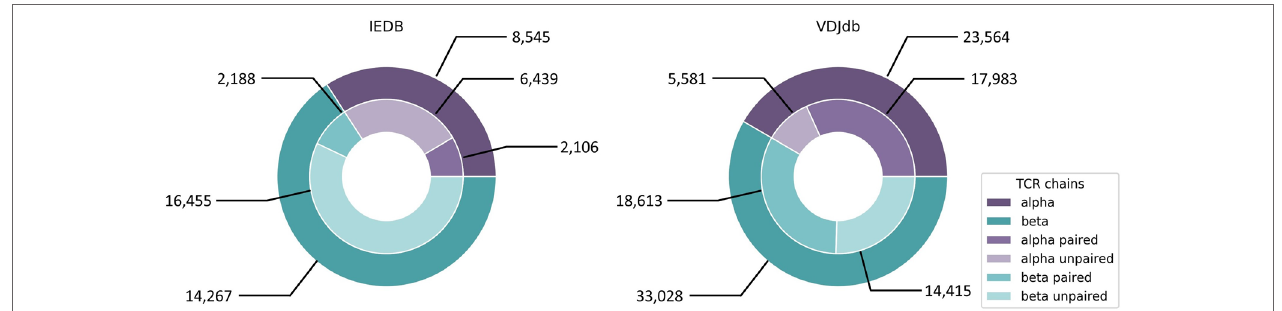
Frontiers in Genetics |